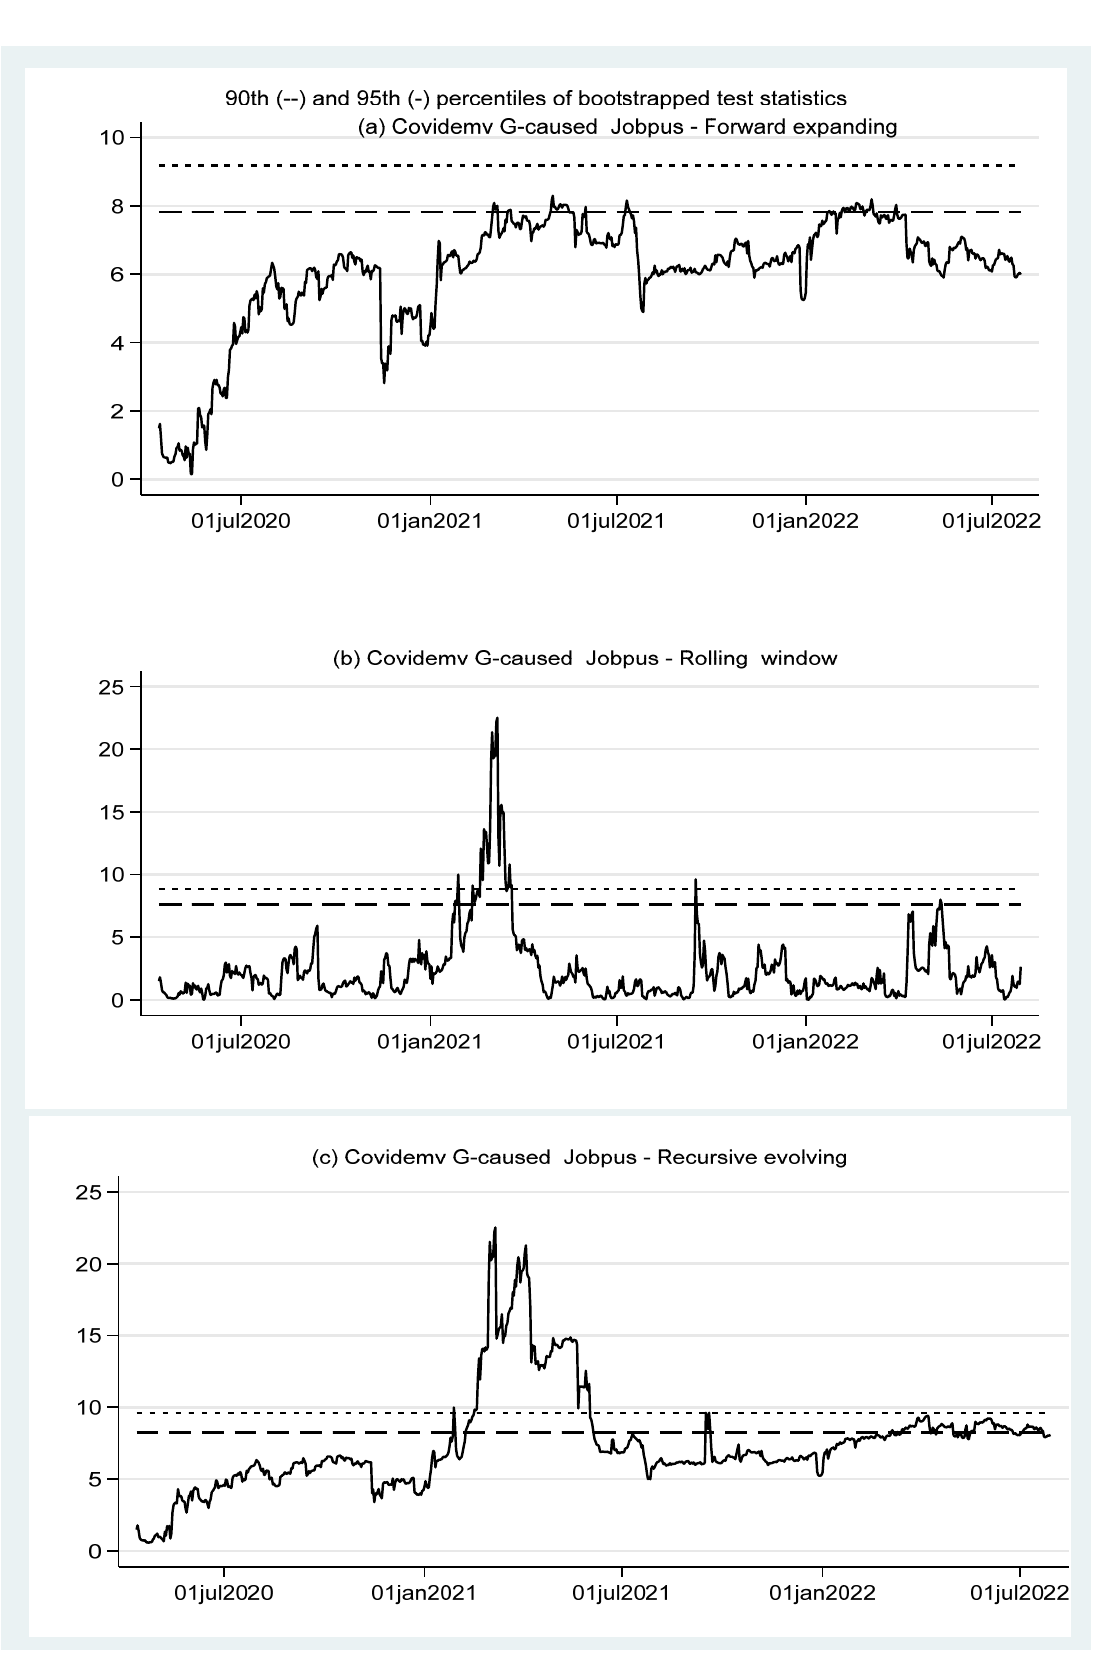
Figure 4. Date stamping the causality behavior between COVIDEMV and manufacturing job postings between 1 January 2020 and 29 July 2022.